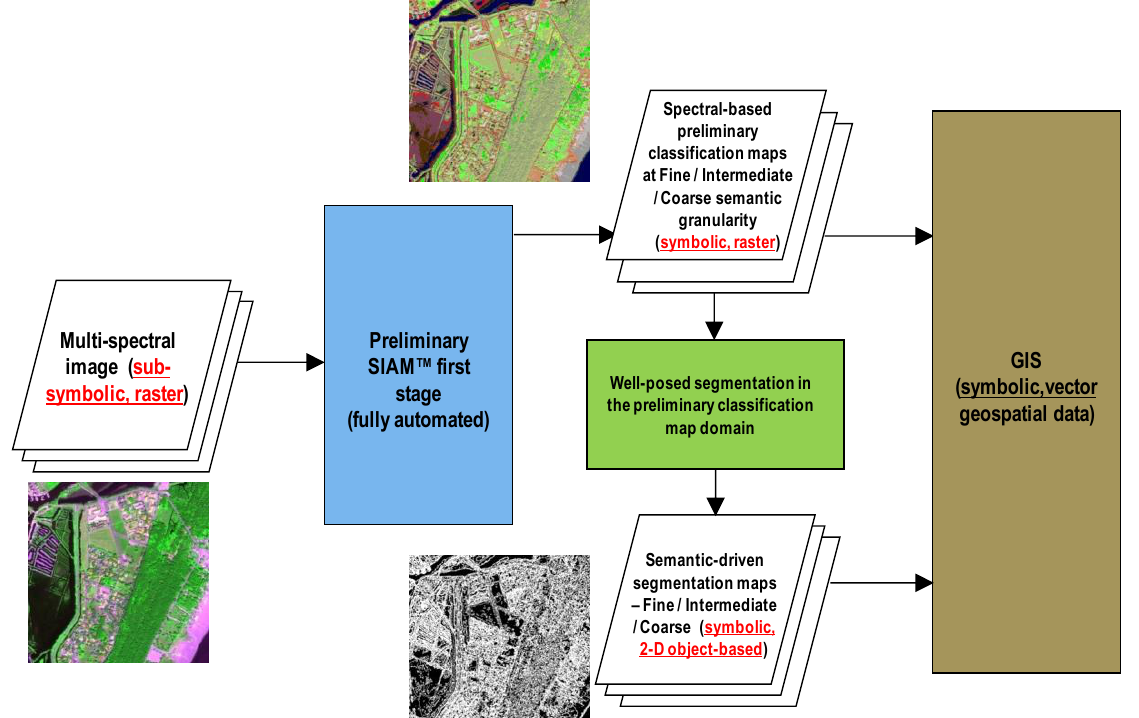
Figure 16. Automatic transformation of sub-symbolic raster RS imagery into symbolic vector geospatial information available in a Geographic Information System (GIS)-ready format through